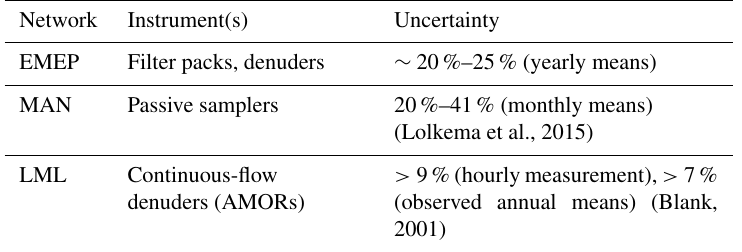
Table 1. Type of instruments used to measure ambient NH 3 concentrations and associated uncertainty